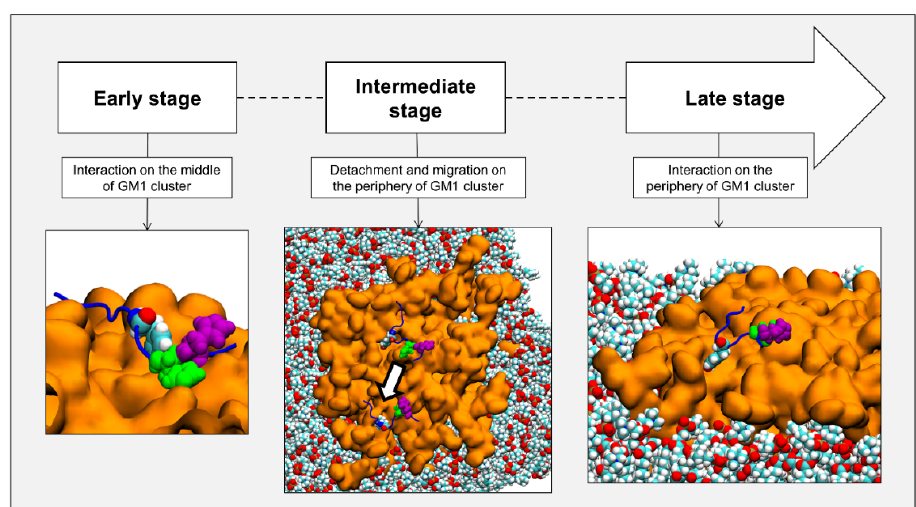
Figure 2. Chronologic events encountered by AmyP53 in our simulations. Gangliosides are depicted as orange surface, POPC phospholipids are depicted as spheres colored by atom name, and AmyP53 is represented as blue cartoon. Y6 is depicted as spheres colored by atom name, H9 is depicted as green spheres, and H10 is depicted as purple spheres.